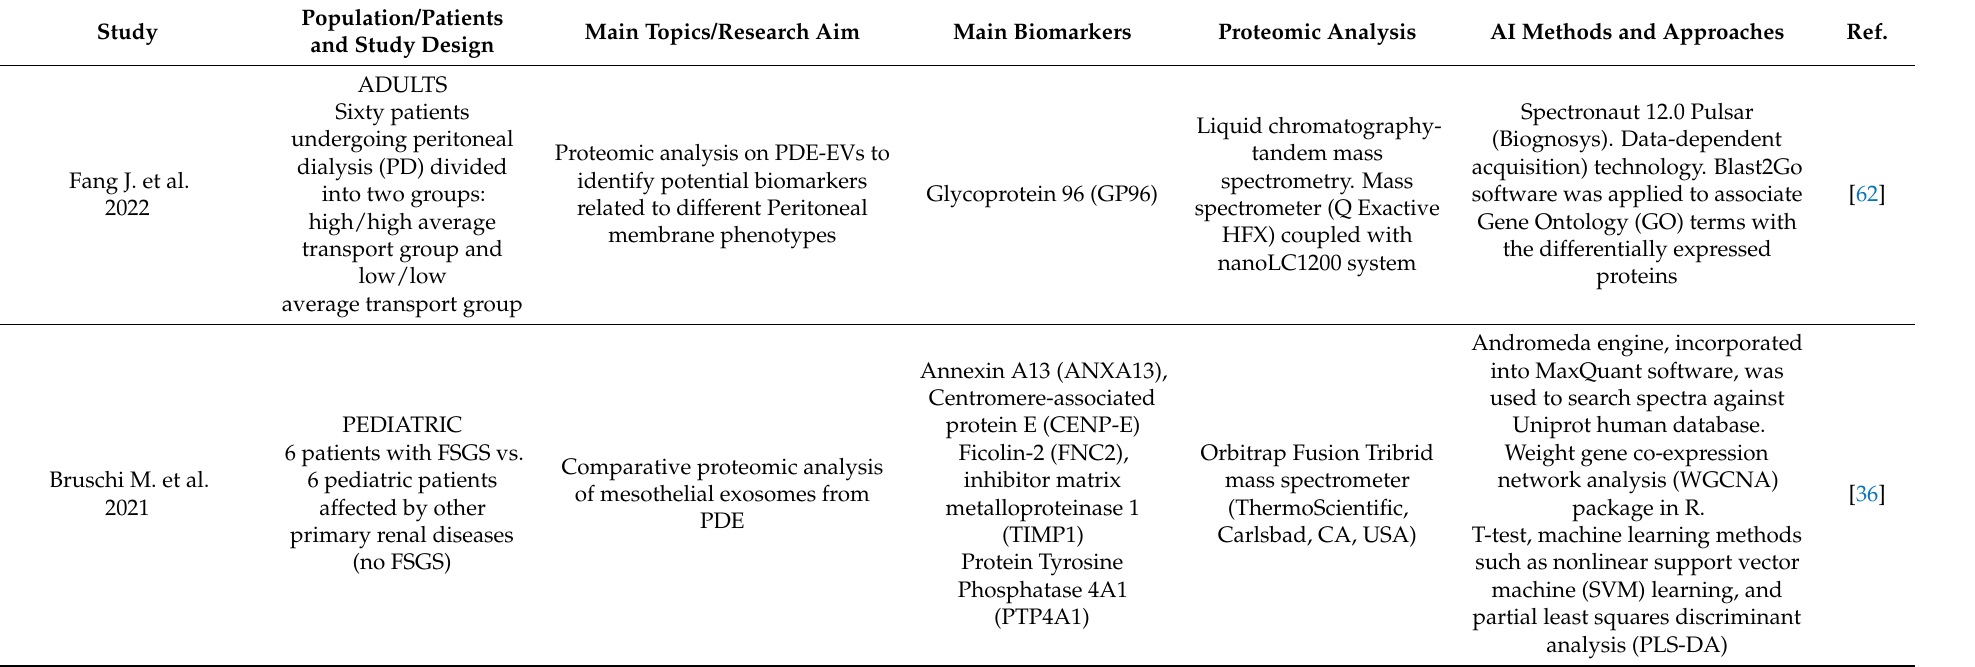
Table 2. Studies published on proteomic analysis in PD in children and proteomic analysis on PDE-derived